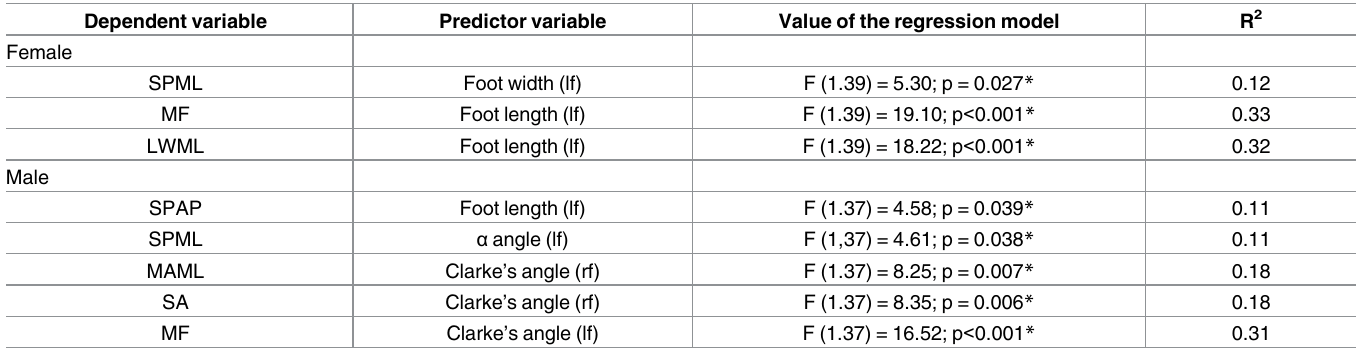
Table 5. Statistically significant models of forward stepwise regression.